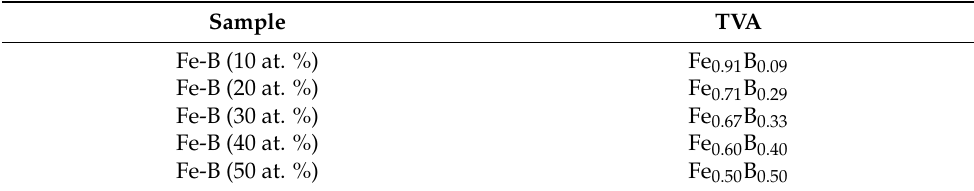
Table 3. Atomic composition of samples Fe-B obtained by